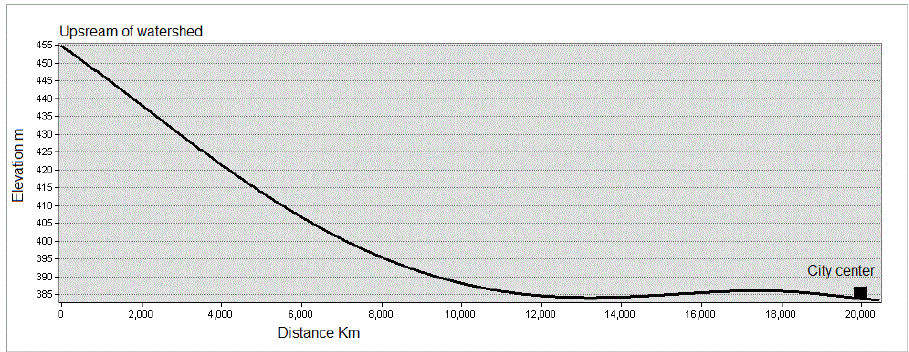
Figure 11. Comparison of upstream elevation and the centre of Erbil city.